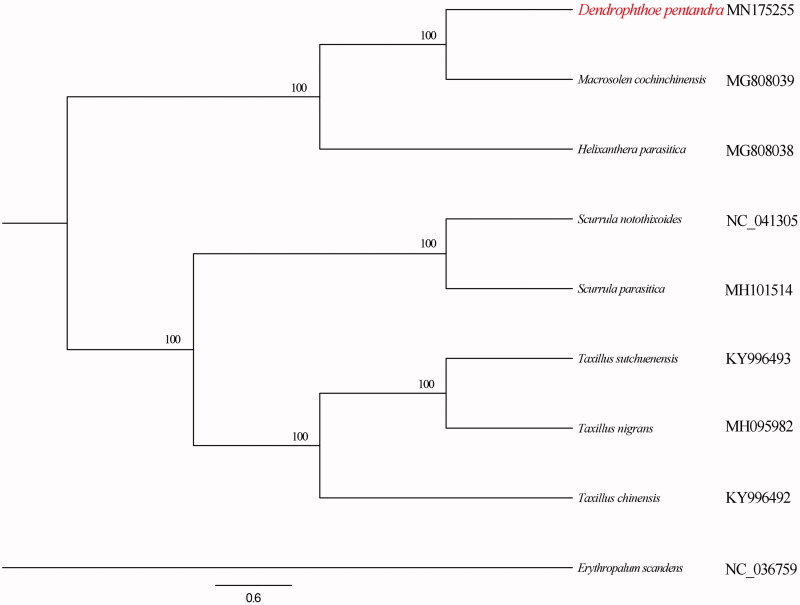
Phylogenetic relationships among Loranthaceae species, based on ML analysis of complete plastomes. The number on each node indicates bootstrap percentage.